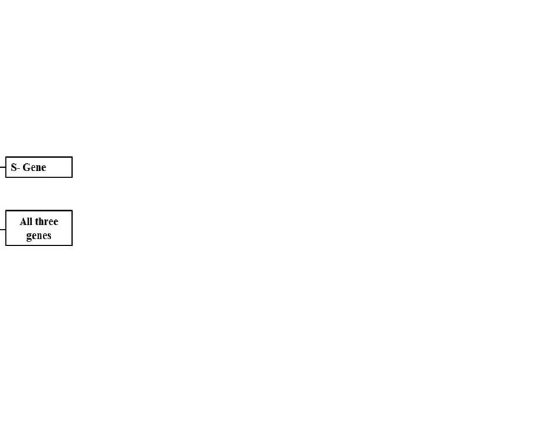
Figure 7. Individual melt curve peak for RdRp gene obtained upon single-plex RT-PCR reaction using primer pairs for RdRp gene.